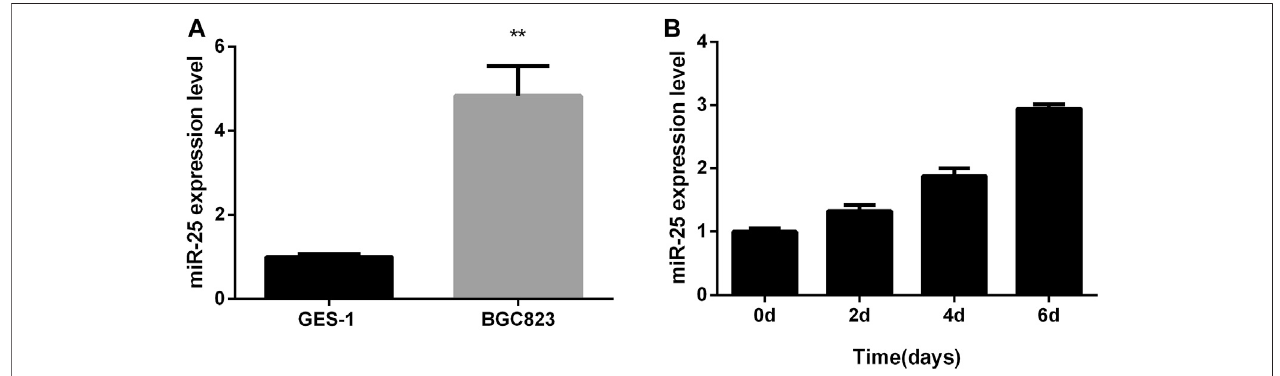
FIGURE 1 | The expression pro fi le of miR-25 in BGC823 cell. (A) The expression level of miR-25 was detected in BGC823 cell and GES-1 cell by RT-qPCR. (B) In different stages (0, 2, 4, 6 days) of culture, miR-25 expression level was detected by RT-qPCR. Value in graphs represents means ± SD. At least three independent experiments were carried out. ** p < 0.01.